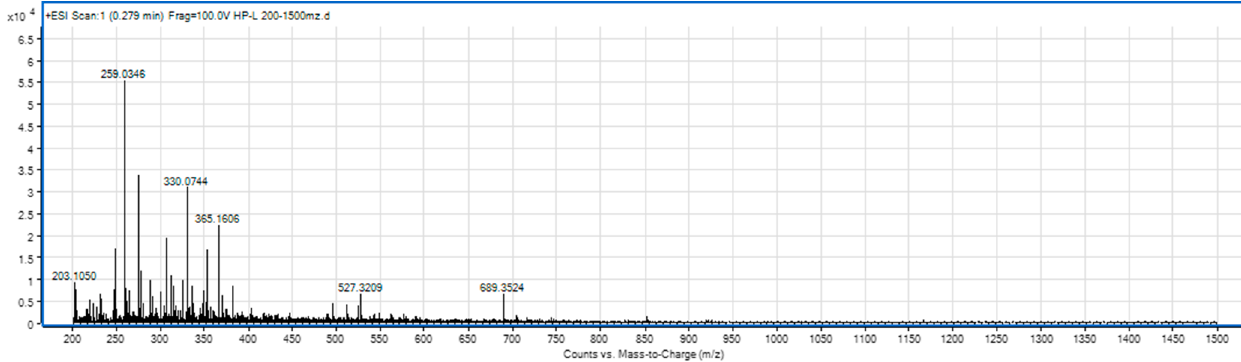
Figure 4. The spectrum of the hydrolysate sample in the domain 200–1500 m / z .